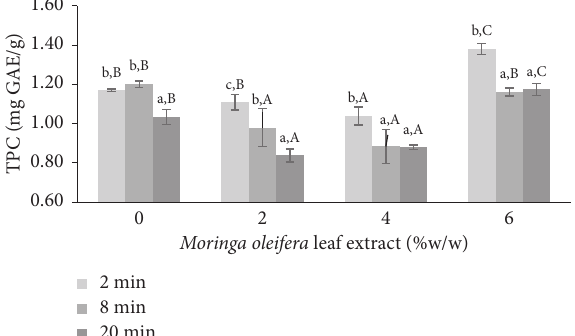
Figure 4: Total phenolic content (TPC) of chocolate alginate beads as affected by MLE concentration (0, 2, 4, and 6% w/w) and hardening time (2, 8, and 20min). Different small letters indicate significant differences among samples of the same concentration, while different capital letters indicate significant differences among samples of the same hardening time at p < 0 .